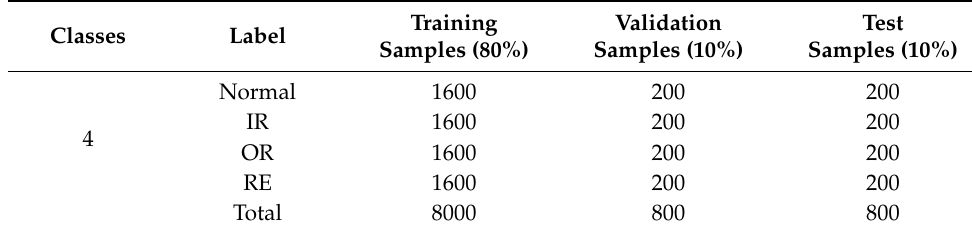
Table 6. Details of the dataset.